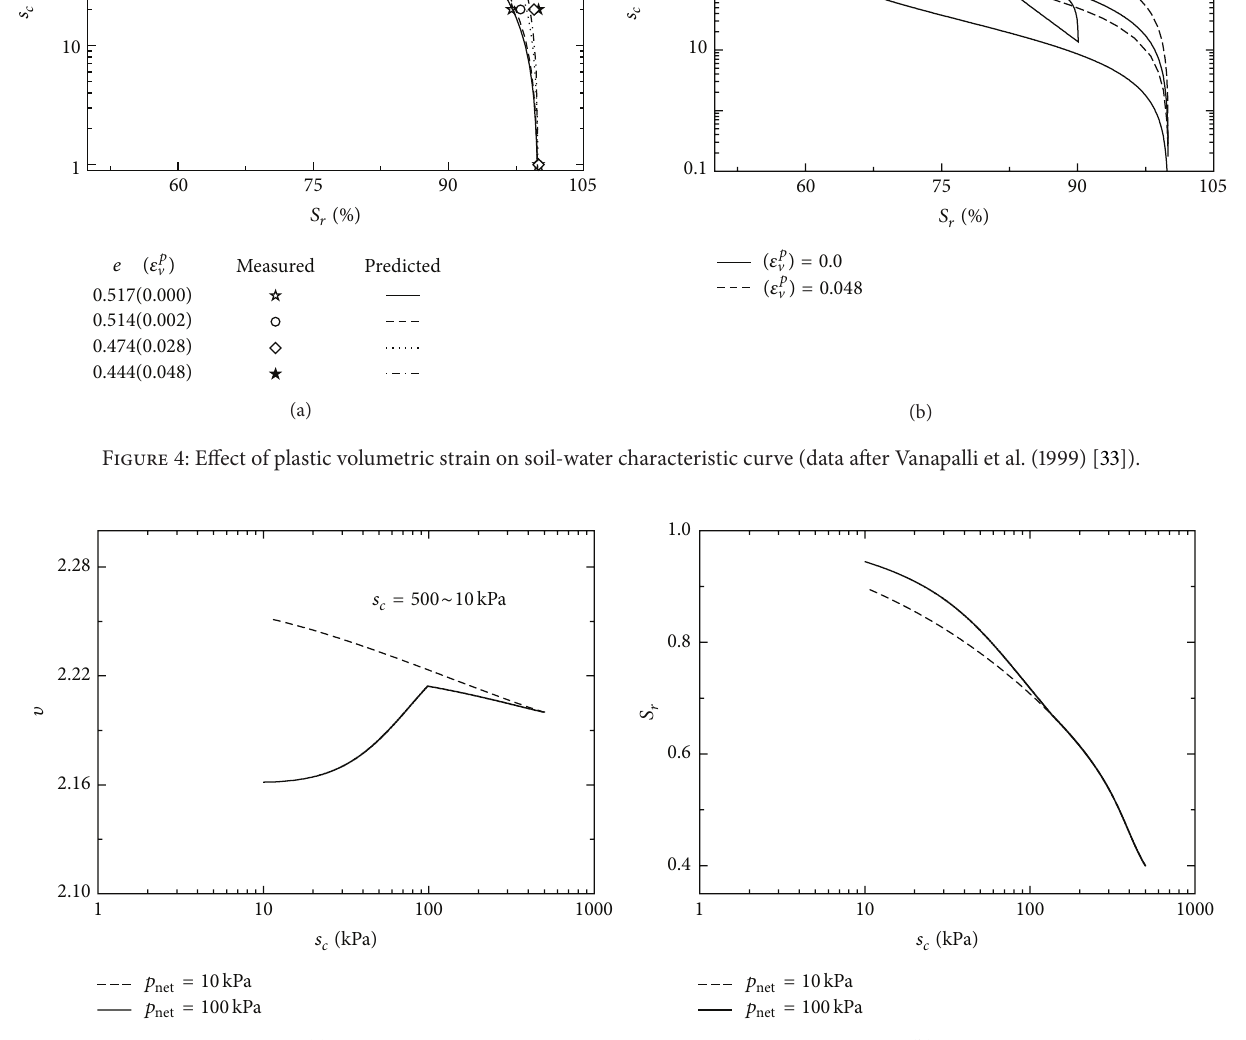
= 290 kPa, 𝑏 0 = 30 kPa, 𝑆 irr = 0.3 , 𝑑 0 = 𝑑 0 = 1.0 , 𝛼 = 3500 kPa, 𝛼 = 1500 kPa, 𝑟 DR WT DR WT DR WT = 0.25 V , max